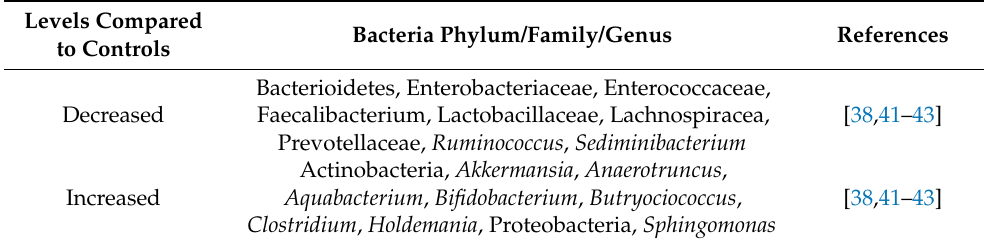
Table 1. Summary of significant changes in populations of bacterial taxa observed in gut microbiome studies of Parkinson’s disease (PD)